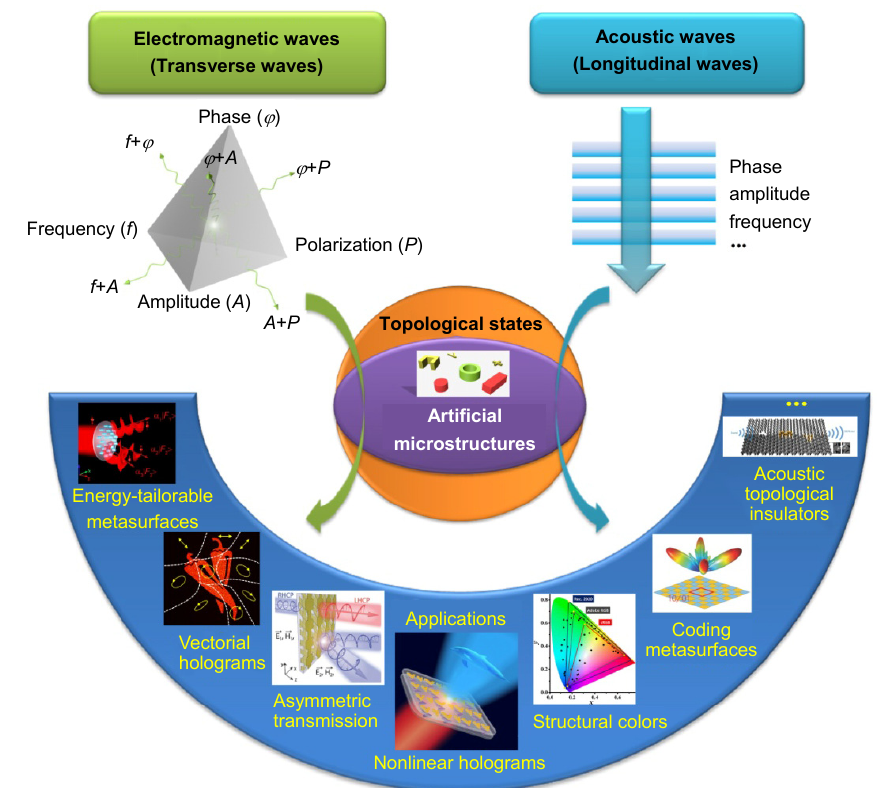
Fig. 1 | Overview of the multidimensional manipulation of wave fields based on artificial